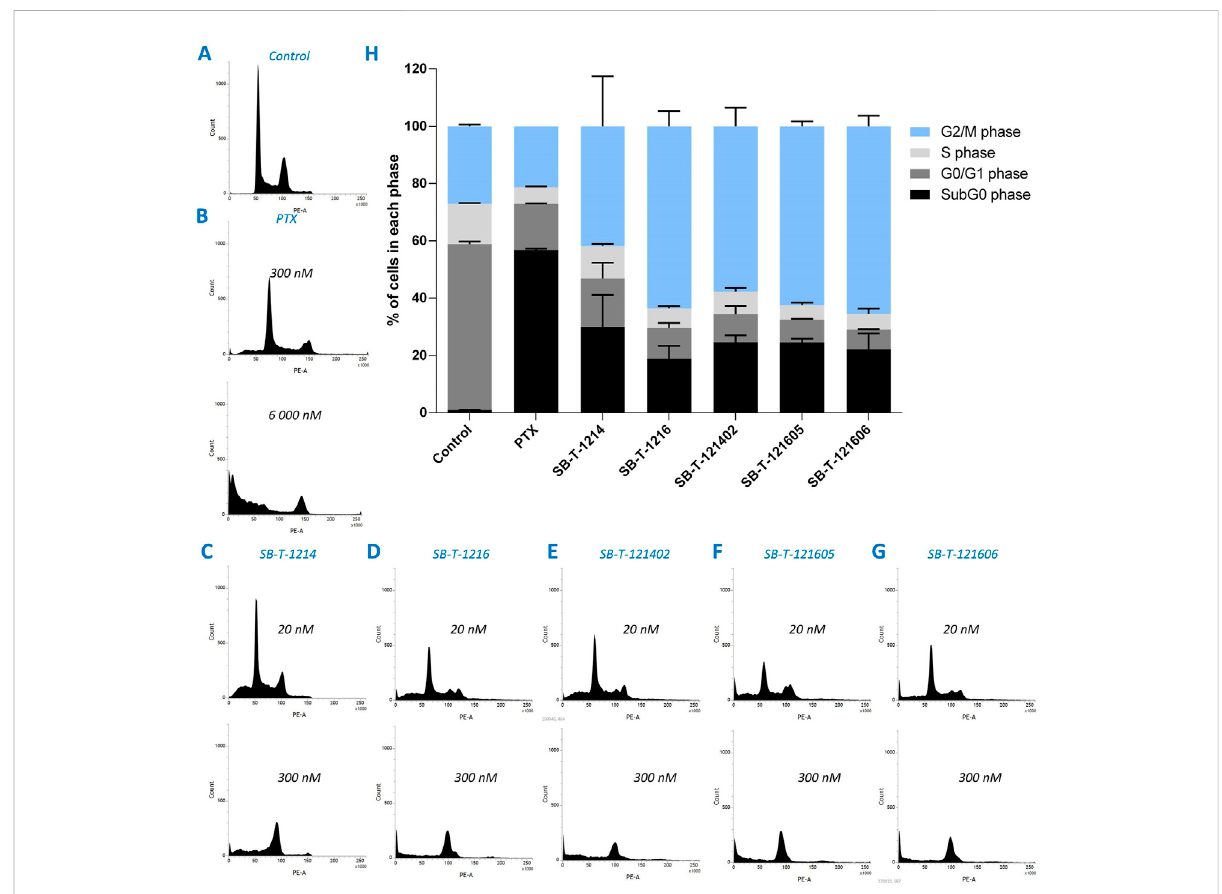
FIGURE 5 Visualizationof thedistributionof cell cycle phases inNCI/ADR-RES cells incubatedwith pure medium (A) ,PTX (B) , and different SB-Ts at20 or 300 nM concentration (C – G) . Cell cycle analysis (H) shows percentage of cells in different cell cycle phases for 6000 nM PTX and 300 nM SB-Ts. Error bars present standard deviation of two individual experiments.